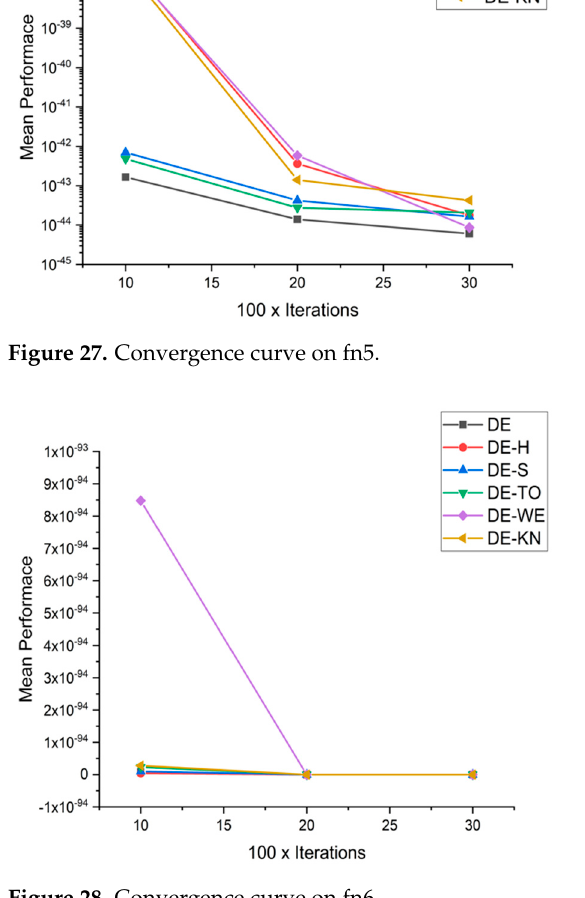
Figure 29. Convergence curve on fn7. Figure 30. Convergence curve on fn8.